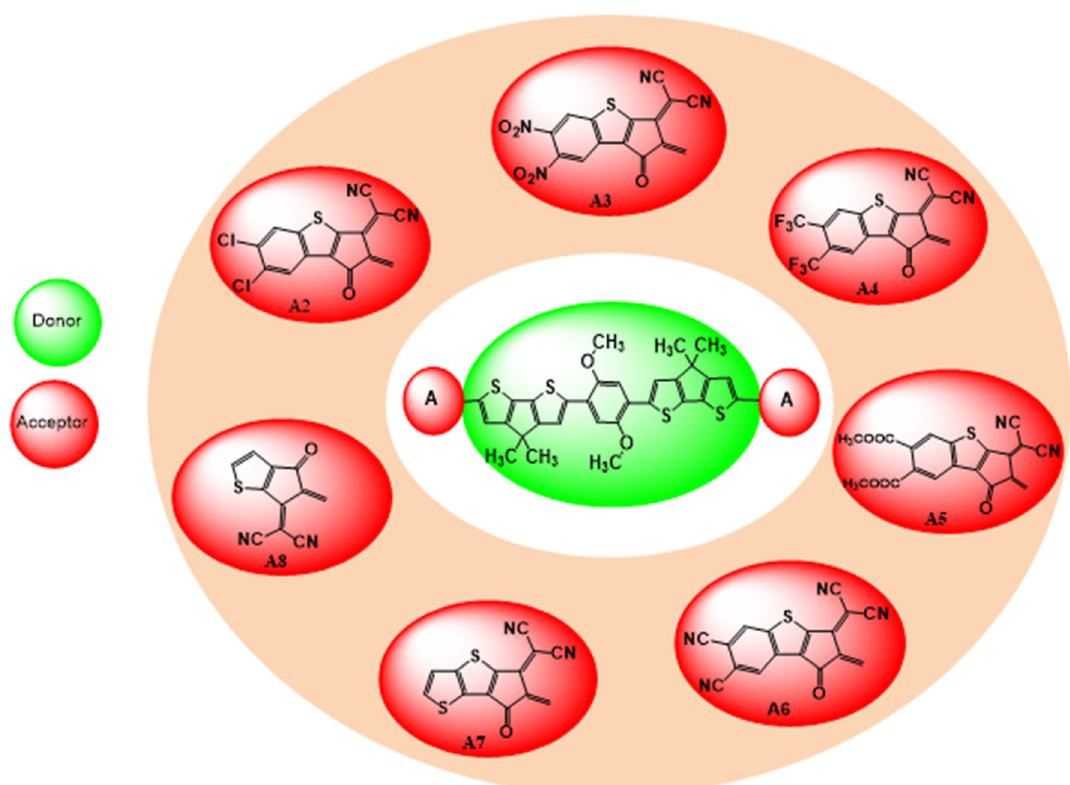
Figure 2. The sketch map of the reference and its derivative